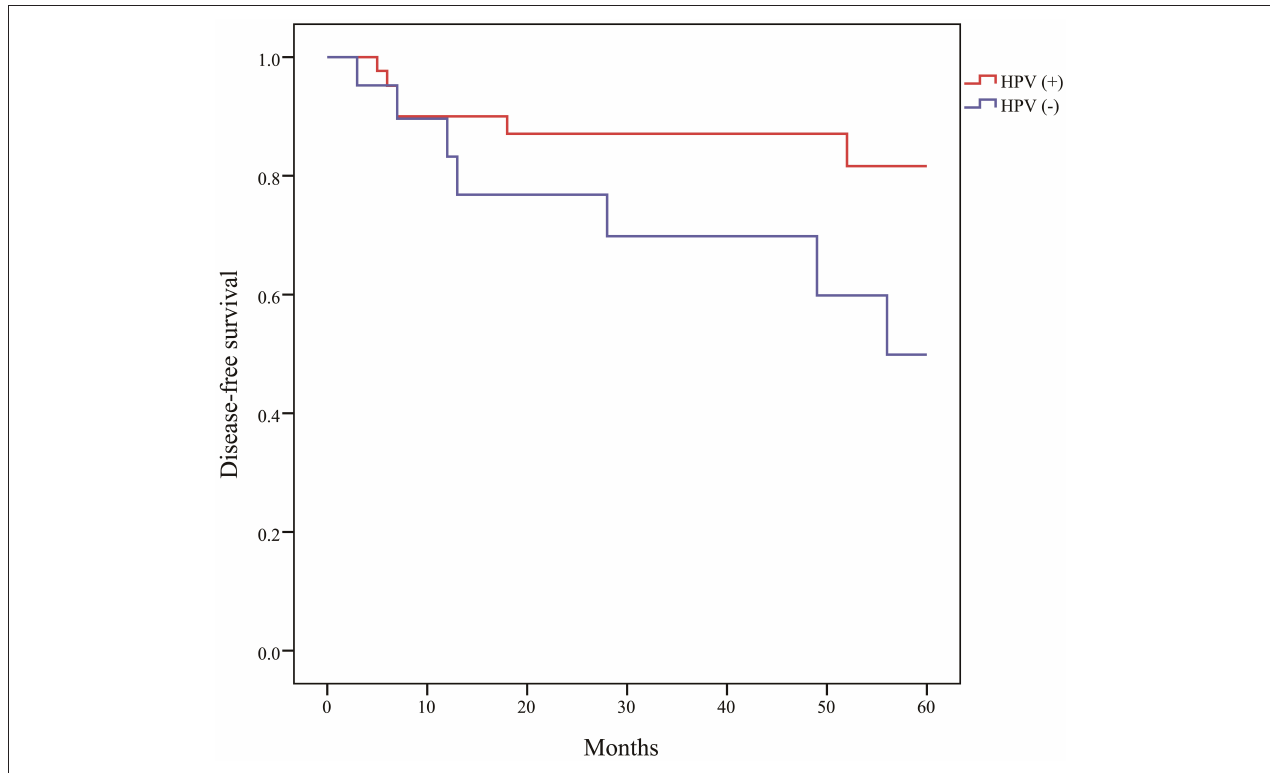
FIGURE 3 | Disease-free survival of oropharyngeal squamous cell carcinoma according to human papillomavirus (HPV) status ( P = 0.028).